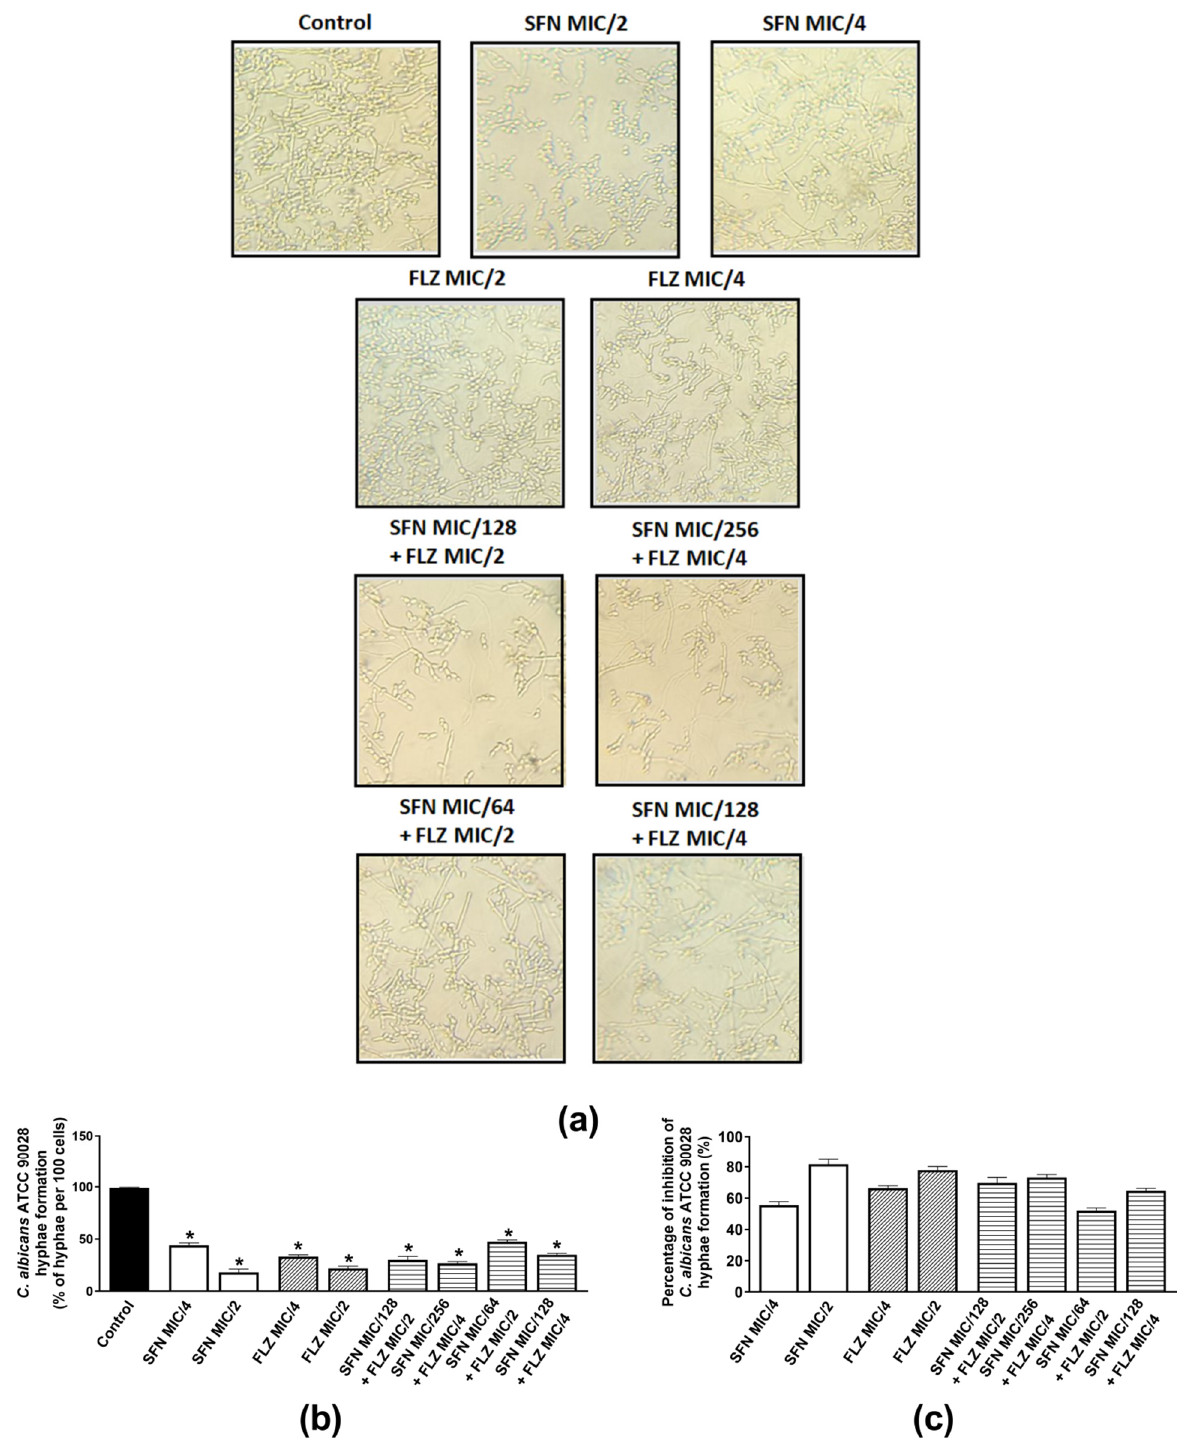
Figure 1. Effects of sulforaphane (SFN) and fluconazole (FLZ) on hyphae formation by C. albicans ATCC 90028. ( a ) Representative images of hyphae growth by C. albicans ATCC 90028 incubated with either FLZ or SFN at MIC/2 and MIC/4. The same panel represents the combined effects of SFN (MIC/64 to MIC/256) and FLZ (MIC/2 and MIC/4). ( b ) Percentage of hyphae per 100 cells of C. albicans ATCC 90028 and ( c ) percentage (%) of inhibition of C. albicans ATCC90028 hyphae formation. The control consisted of inoculum plus phosphate-buffered saline (PBS) containing 10% fetal bovine serum (FBS). * p < 0.05 differs from the control group.